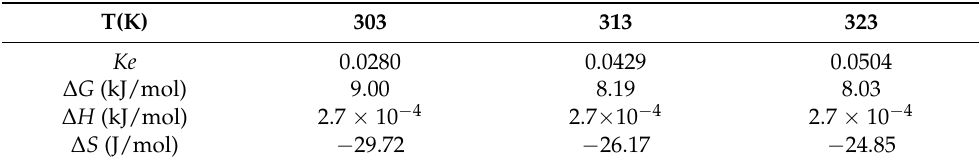
Table 7. Thermodynamics parameters at different temperatures.